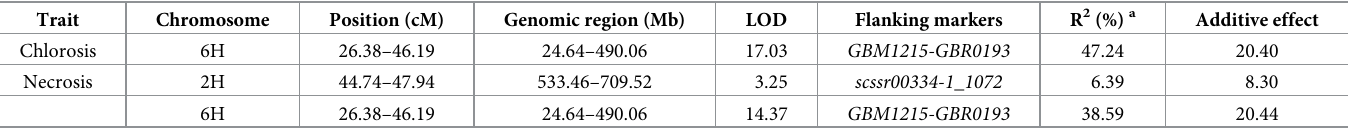
Table 1. QTL peaks on 2H and 6H for Cd-tolerance in the OWB mapping population. Trait